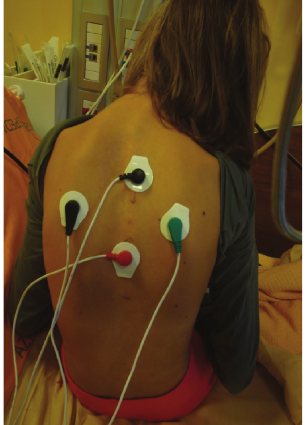
Figure 4: Sites where electrodes were attached.